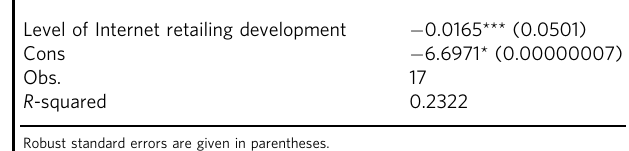
Table 5 Regression analysis results for the selected key